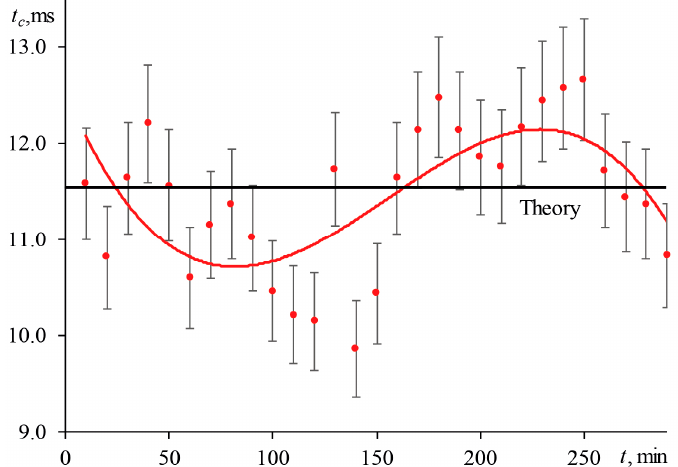
Figure 5. The behavior of the characteristic time of an aqueous solution of ferroin (2.5 µmol/L); wide- focused configuration ( 𝜔 (cid:3032)(cid:2868) = 82 µm, Figure 2, Table 3).